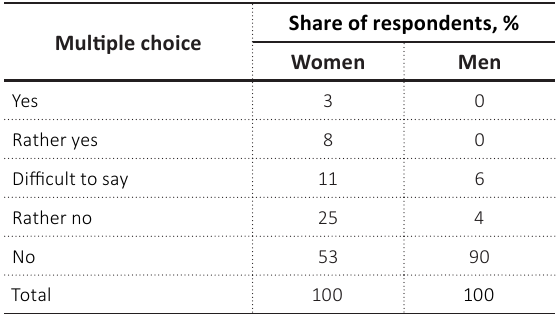
Table 9. Respondents’ answers to the question “Do you think your gender impedes your career development?”